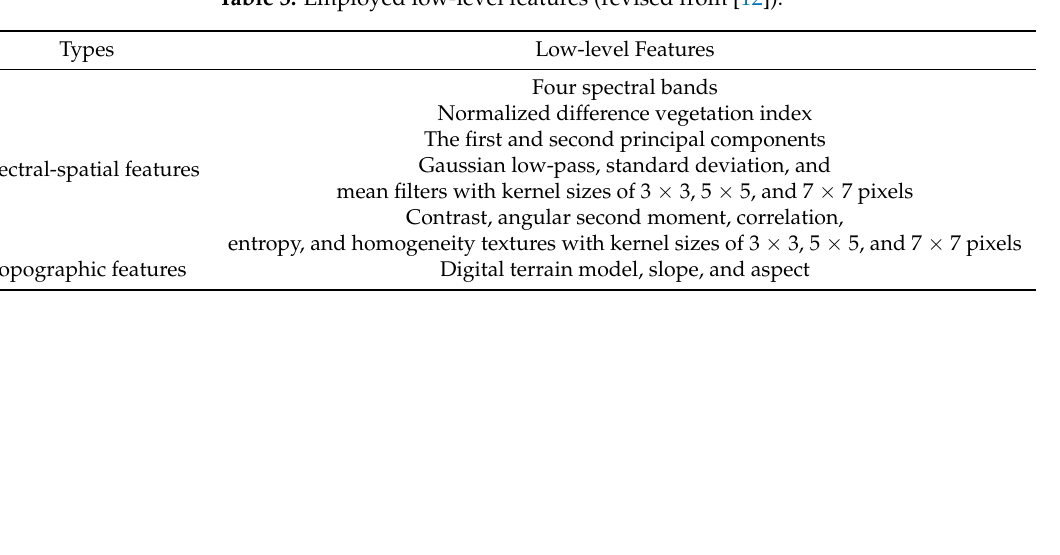
Table 3. Employed low-level features (revised from